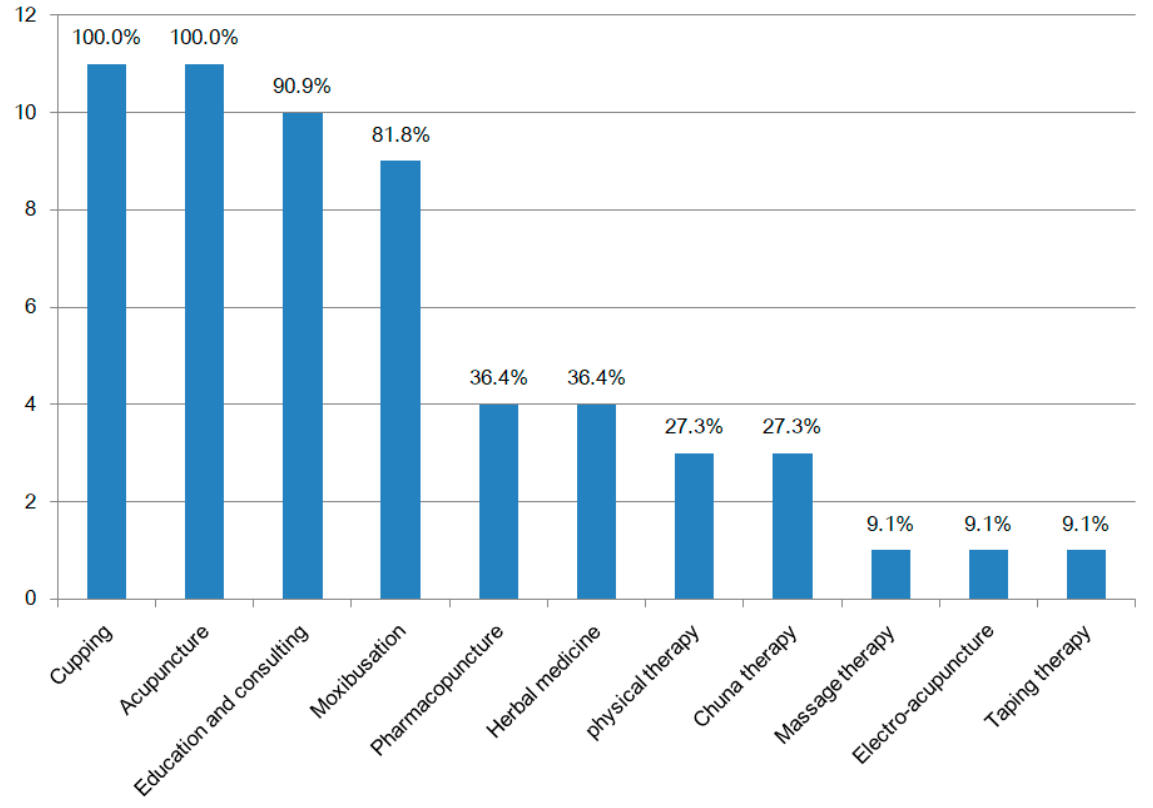
Figure 3. Current status of community home care of TKM Intervention. TKM: Traditional Korean medicine. Table 4. Satisfaction with TKM Service